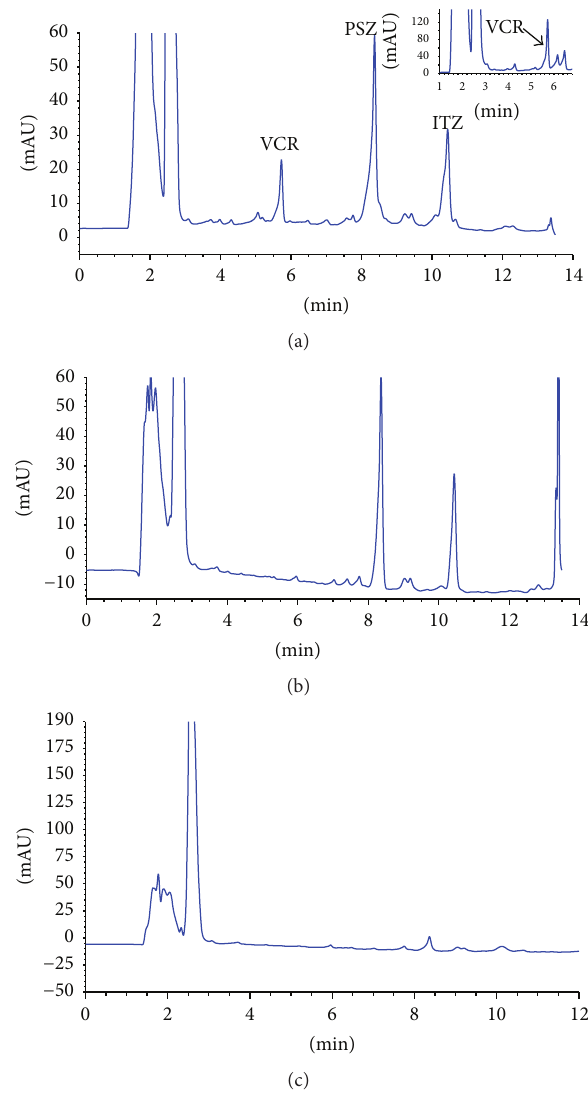
Figure 1: Chromatogram of (a) rat plasma spiked with 2500 ng/mL ofVCRandPSZ,(b)ratplasmaobtainedafter6 hoforalPSZdosing, and (c) blank rat plasma measured at 262 nm. The inset shows a section of a chromatogram for rat plasma spiked with 2500 ng/mL of VCR measured at 220